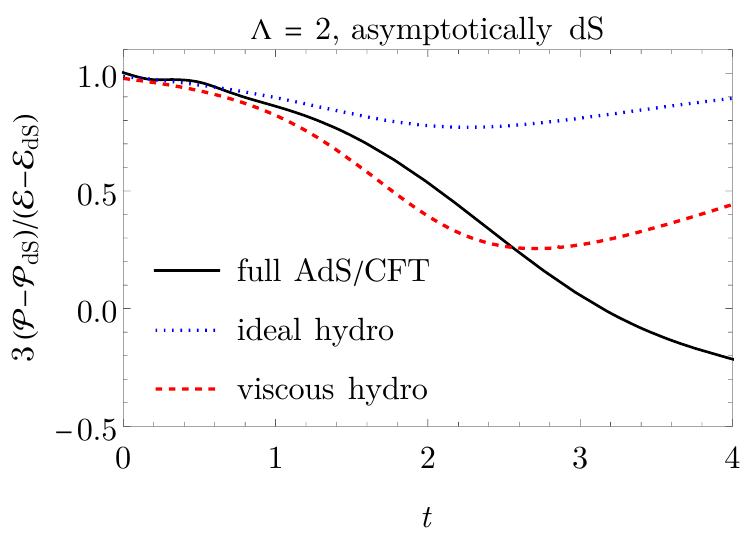
Figure 6 . Same as in figure 5 but for Λ = 2